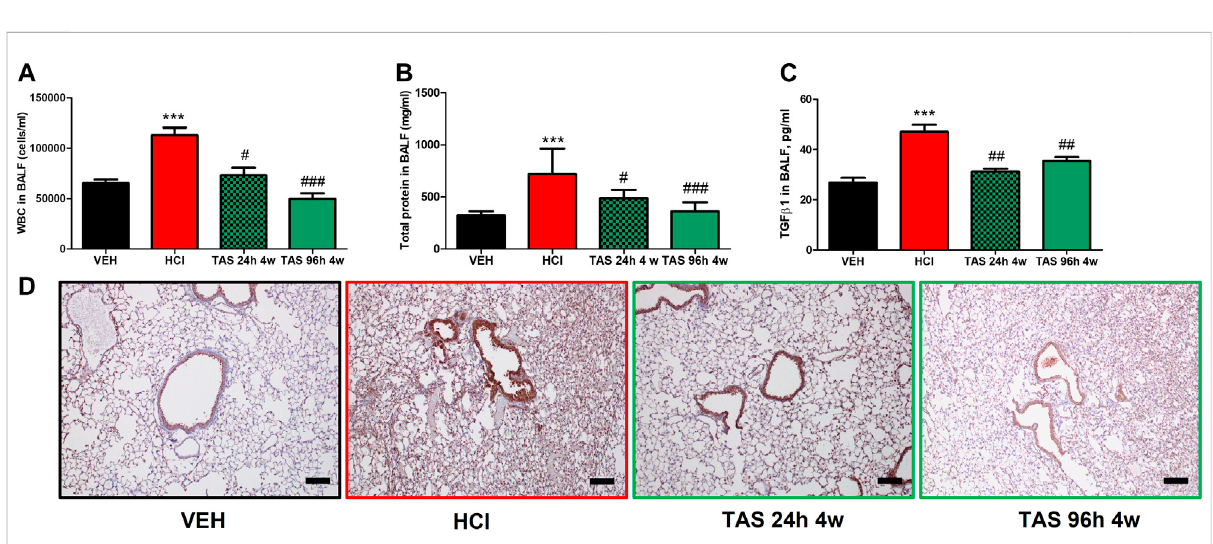
Oral treatment with TAS-116 — starting either 24 or 96 ° h after HCl-ameliorates alveolar in fl ammation. (A) White blood cells, (B) Total protein concentration and (C) TGF- β content in bronchoalveolar lavage fl uid (BALF) at 30 ° days post HCl instillation and treatment with TAS-116 at 7 mg/kg 5×/weekstarting24or96 hpost-HCl; (D) Immunohistochemicalstainingforthein fl ammasomeNLRP3.Originalmagni fi cation×10;blackscalebars correspond to 100 μ m; n = 6 mice per group; ***: p < 0.01, from VEH; # : p < 0.05, ## : p < 0.01, ### : p < 0.001 from HCl, with 1-way ANOVA and Tukey ’ s post-hoc